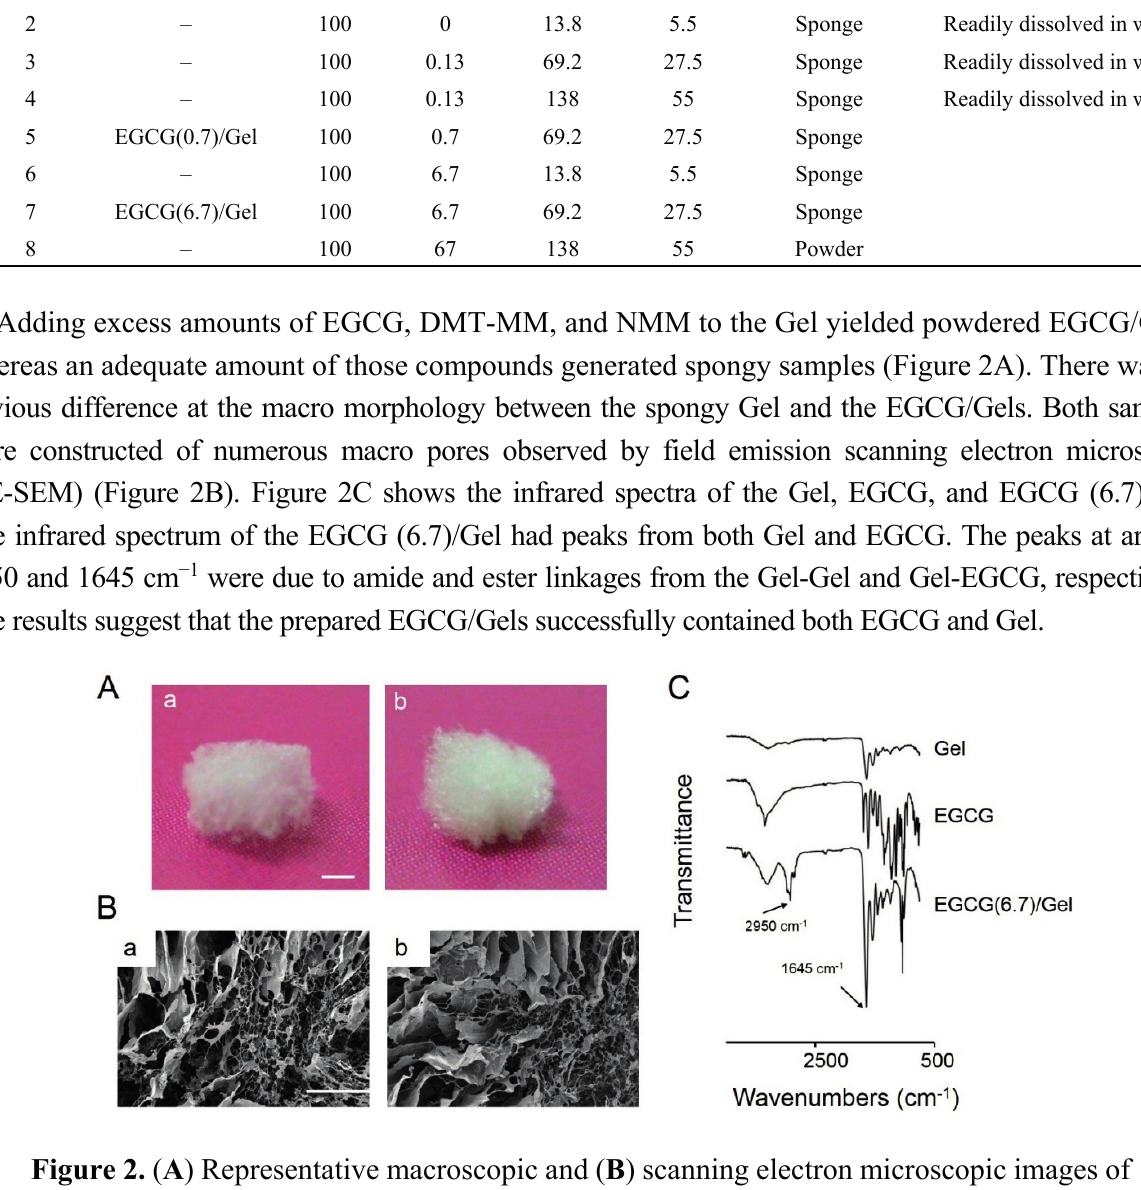
Figure 2. ( A ) Representative macroscopic and ( B ) scanning electron microscopic images of the Gel and EGCG/Gel for ( a ) Gel and ( b ) EGCG (6.7)/Gel; and ( C ) Infrared spectra of Gel, EGCG, and EGCG (6.7)/Gel. Bars: ( A ) 1 mm and ( B ) 300 μ